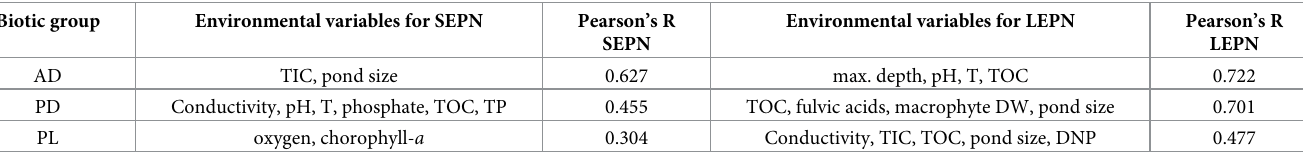
Table 1. Set of environmental variables identified by the BIO-ENV analysis and the overall correlations (Pearson) for each biotic group and pond network. Biotic